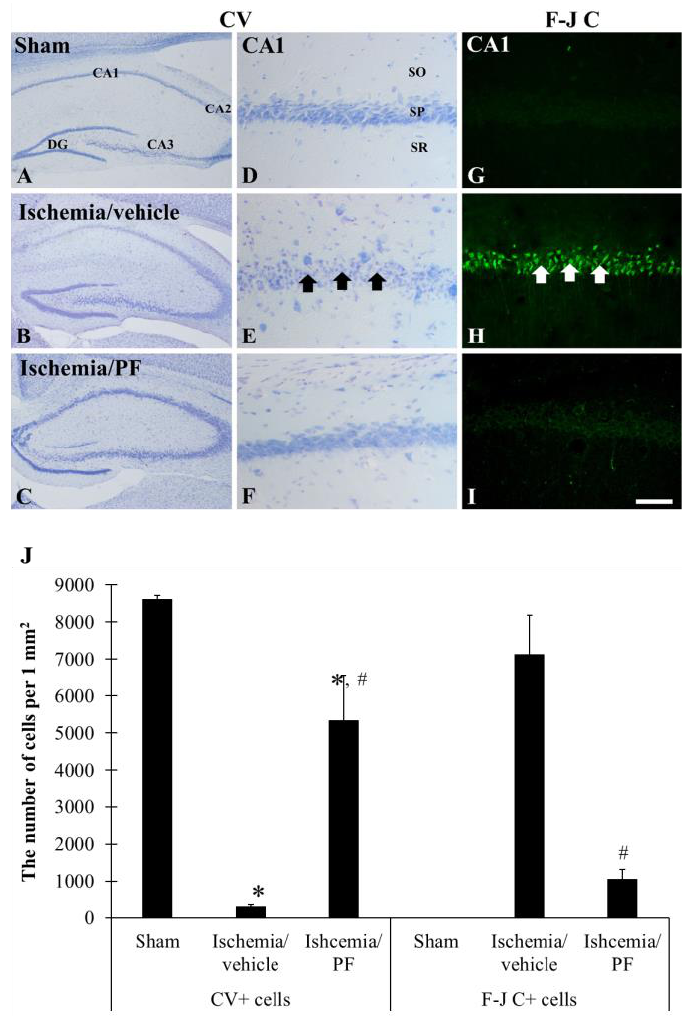
Figure 7. The 75% EEPF neuroprotection of ischemic neuronal damage. Cresyl violet (CV) ( A – F ) and Fluoro-Jade C (F-J C) ( G – I ) staining in the hippocampus ( A – C ) and Cornu Ammonis 1 (CA1) region ( D – I ) of the sham ( A , D , G ), ischemia/vehicle ( B , E , H ), ischemia/PF ( C , F , I ) groups at 5 days after ischemic surgery. In the ischemia/vehicle groups, CV positive (+) cells are significantly reduced (black arrows) and many Fluoro-Jade C+ cells are observed (white arrows) in the stratum pyramidale within the CA1 region. In the ischemia/PF group, CV+ and F-J C+ cell density is close to that in the sham group. Scale bar = 400 μm ( A – C ), 100 μm ( G – I , J ). Number of CV+ and F-J C+ cells in the CA1 region is n = 7 for each group. * p < 0.05 versus sham group, # p < 0.05 versus ischemia/vehicle group. The bars indicate the means ± SEM.